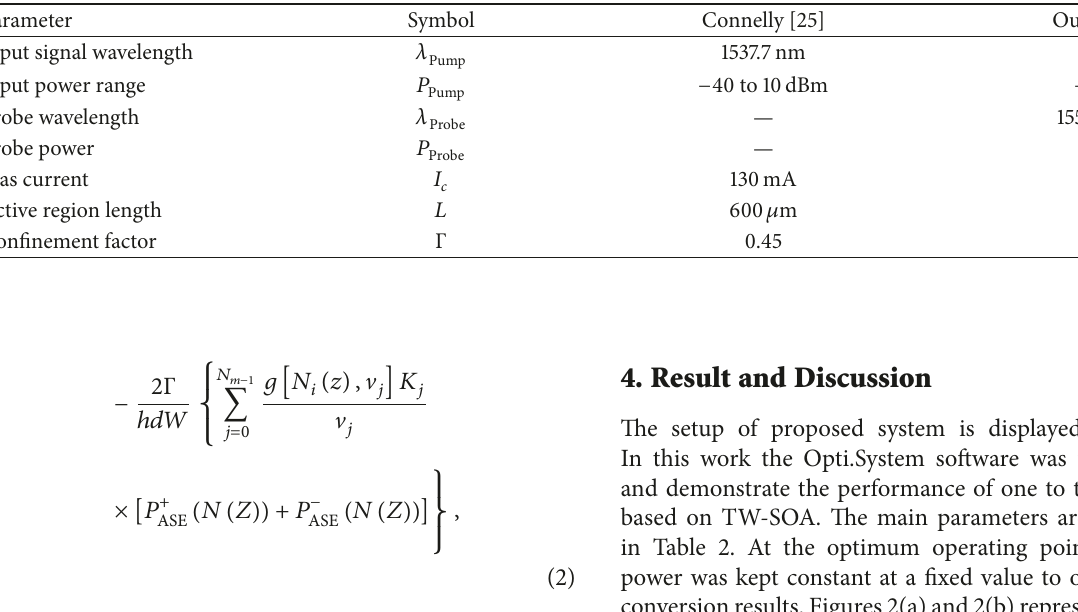
Table 2: Parameters utilized in the